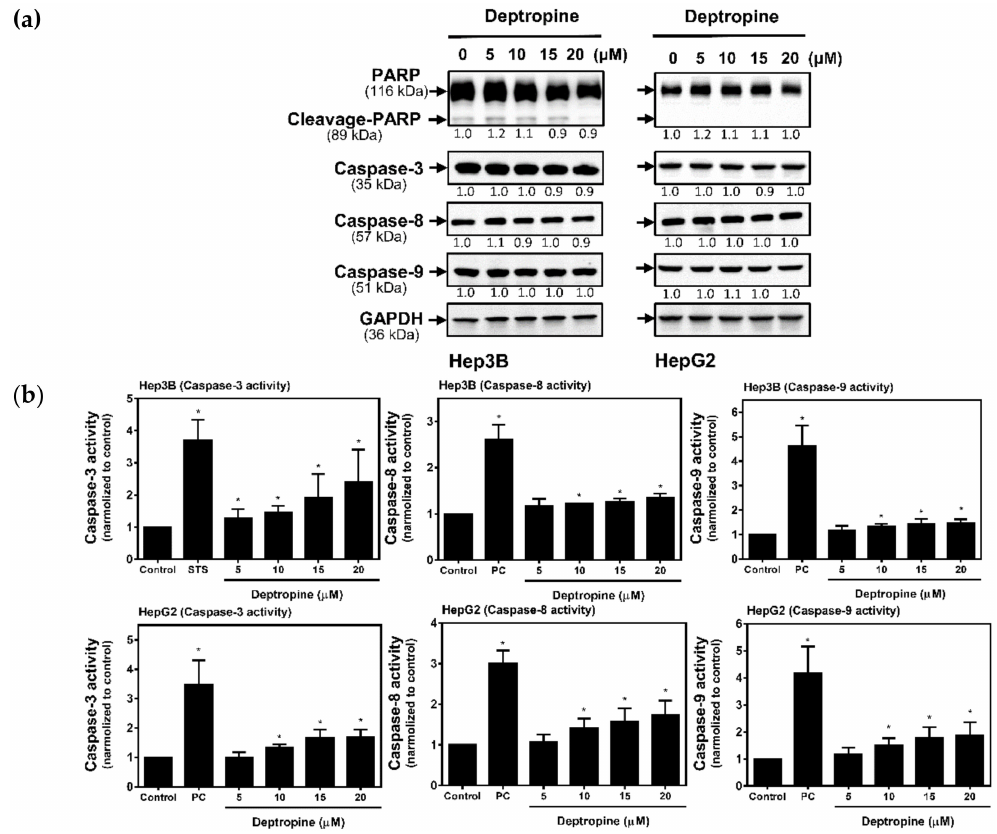
Figure 6. E ff ects of deptropine on caspase expressions and activities in human hepatoma cells. Hep3B and HepG2 cells were treated with di ff erent concentrations of deptropine for 48 h, and ( a ) poly(ADP ribose) polymerase (PARP), caspase-3, -8, and -9 protein expressions were determined by Western blotting. The relative intensity of each band (indicated below the bands) was normalized to the GAPDH loading control. ( b ) The cell extracts were subjected to caspase-3, -8, and -9 activity assays as described in “Materials and Methods”. Values were obtained in two independent experiments performed in triplicate, and results are presented as the mean ± standard error. * p < 0.05 vs. the control. STS, staurosporine (1 µ M) as the positive